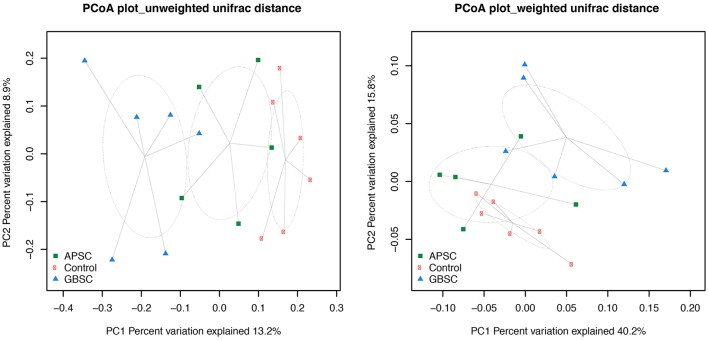
Two-dimensional PCoA plots based on the unweighted and weighted UniFrac distance matrix illustrates variation in rumen fluid bacterial communities as affected by different subacute ruminal acidosis (SARA) challenge conditions. The ellipses were drawn with standard errors of the points at 0.95 confidence limit. Labels are placed at means centers of each site and are linked to each sample of the corresponding site. Abbreviations in figure: APSC, alfalfa-pellet SARA challenge; GBSC, grain-based SARA challenge. Significance levels unweighted analysis, APSC vs. Control P = 0.01; GBSC vs. Control P < 0.01; GBSC vs. APSC P = 0.15. Significance levels weighted analysis, APSC vs. Control P = 0.22; GBSC vs. Control P < 0.01; GBSC vs. APSC P = 0.06.